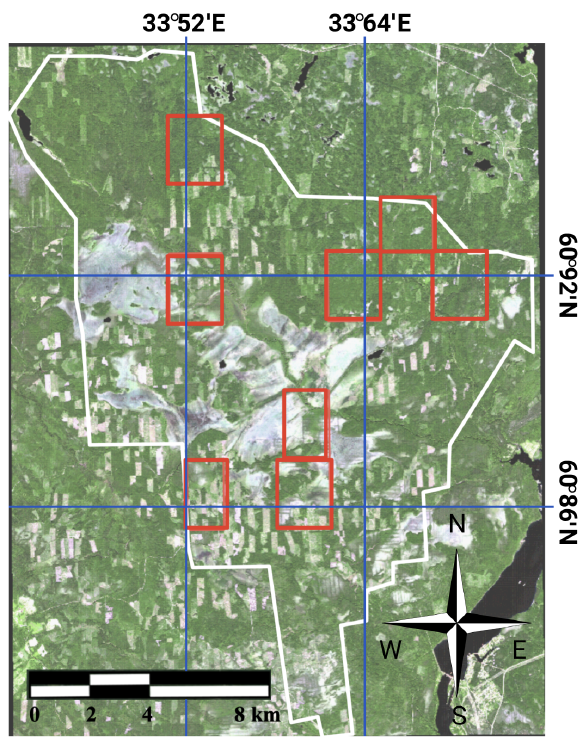
Figure 5. The whole study area (white polygon). Test regions (red polygons). Enhanced RGB bands of Sentinel-2 image (tile id is L2A_T36VWN_A010343_20170615T090713) are